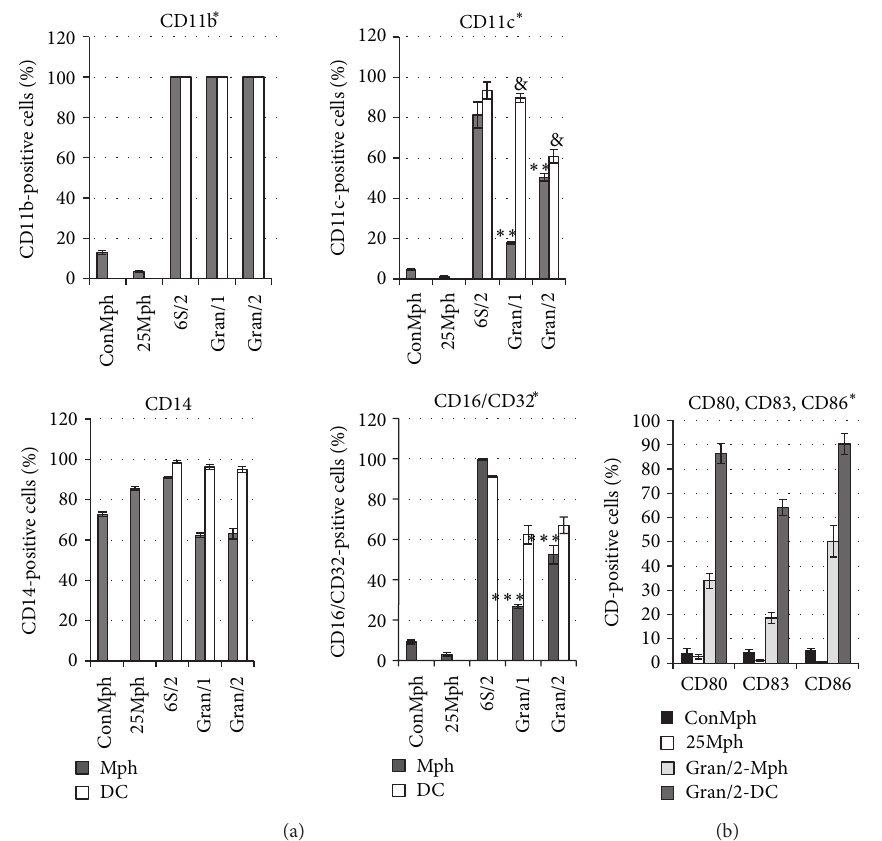
Figure 4: The macrophages (Mph) and dendritic cells (DC) with cell surface markers (a) CD11b, CD11c, CD14, CD16/CD32 and (b) CD80, CD83, CD86. The independently examined objects are control peritoneal macrophages (ConMph) from three intact mice, peritoneal macrophages obtained from mouse 25 (25Mph) after being intraperitoneally infected with the BCG vaccine for two months, cells in leukocyte infiltrates from mouse 6S/2 and granulomas from the spleens of three to five mice after one and two months (Gran/1 and Gran/2, resp.) of BCG infection in vivo and ex vivo culture after a few days. Gran/2 granulomas of 12 mice were analyzed for CD11b. Data are means ± SEM. ∗ 𝑃 < 0.001 (comparing CD-positive macrophages in controls (ConMph and 25Mph) and Gran/1 and Gran/2 granulomas), ∗∗ 𝑃 < 0.05 , ∗∗∗ 𝑃 < 0.01 , & 𝑃 < 0.01